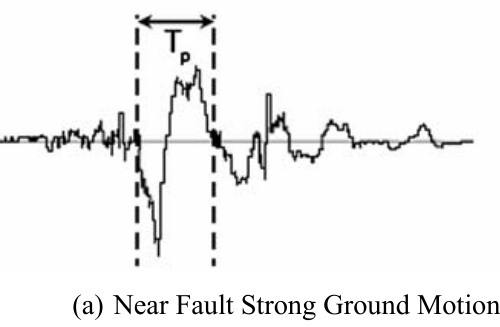
Fig. 1. The time-histories of two different strong ground motion velocities.